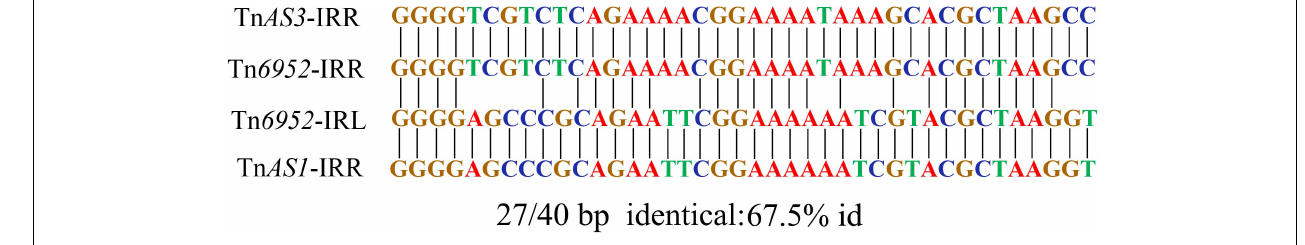
FIGURE 5 | Alignment of the IRR and IRL in Tn 6952 with the IRs identified on the Tn AS3 and Tn AS1